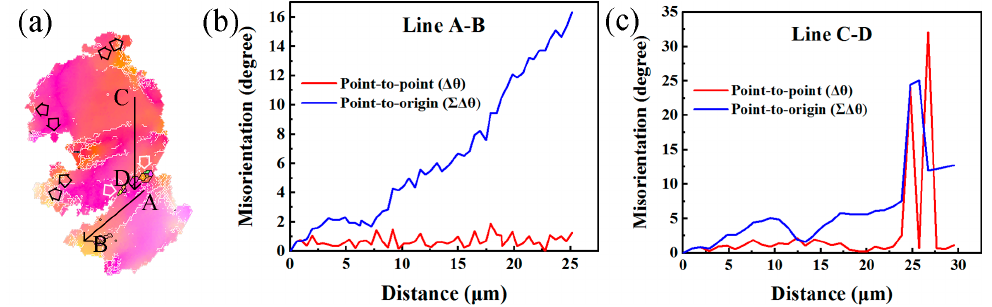
Figure 6. ( a ) Extracted grains from the edge of sample #2 (highlighted by yellow dashed boxes in Figure 5b), and ( b , c ) show the typical point-to-point and point-to-origin misorientations along lines AB and CD marked in ( a ).